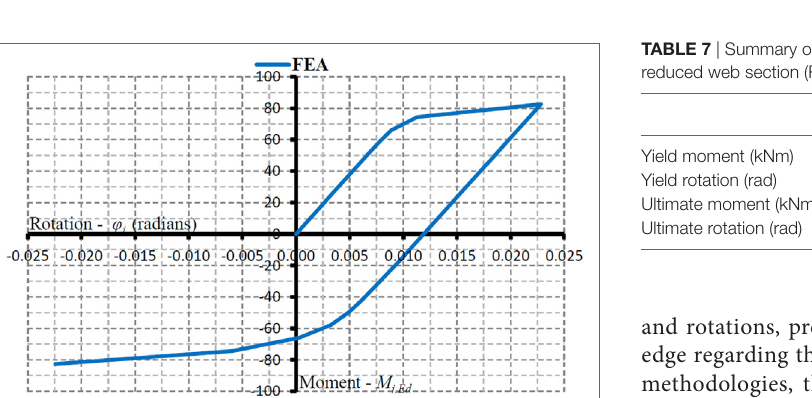
Figure 13 | Hysteretic moment–rotation curves from validation study (Sofias et al., 2014) reproduced with permission from the copyright holder.